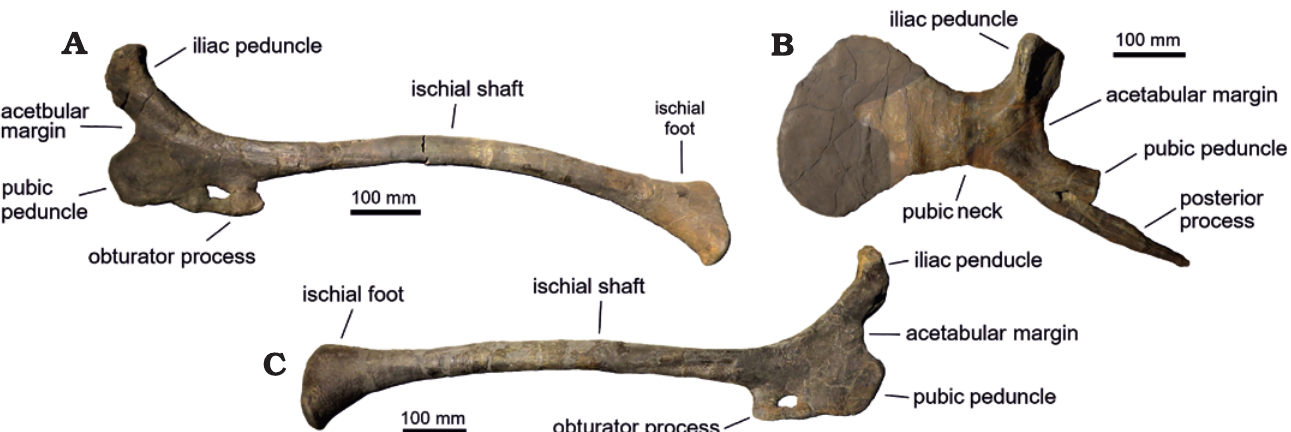
Fig. 9. Pelvic gridle elements of hadrosaurid dinosaur Velafrons coahuilensis Gates, Sampson, Delgado de Jesús, Zanno, Eberth, Hernandez-Rivera, Aguillón-Martínez, and Kirkland, 2007 (CPC 59) from Rincón Colorado, Coahuila, Mexico, upper Campanian. A . Left ischium in lateral view. B . Left pubis in lateral view, shading indicates the reconstructed area. C . Right ischium in lateral